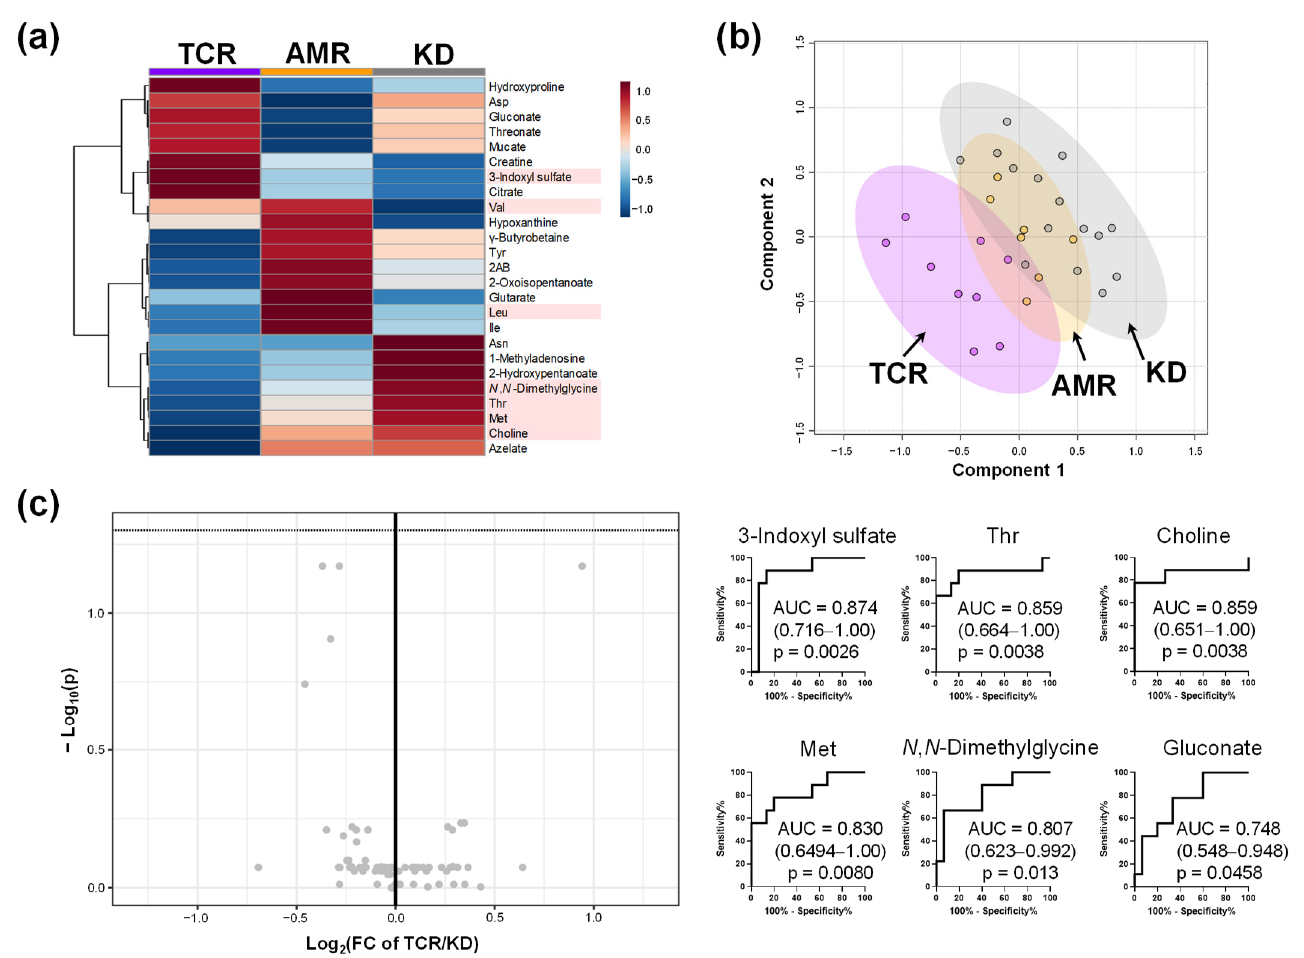
Figure 3. The difference in the plasma metabolomic profile of participants with kidney transplantation (groups TCR, AMR, and KD). ( a ) Heatmap of metabolomic profile. The processing is the same as the legends in Figure 1a. Subsequently, the data were averaged for each group. No metabolite shows FDR-adjusted p < 0.05; ( b ) Score plots of PLS-DA using the metabolites shown in panel ( a ) . R 2 and Q 2 of leave-one-out-cross-validation are 0.82 and 0.51, respectively; ( c ) Volcano plots between TCR and KD. The horizontal line indicates − log 10 (P) = 1.3, i.e., FDR-adjusted p = 0.05. The area under the receiver operating characteristic (ROC) curves (AUC) is shown for the metabolites with p < 0.05 (without FDR correction). TCR, T cell-mediated rejection group; AMR, antibody-mediated rejection group; KD, kidney dysfunction other than rejection